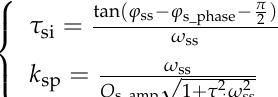
Closed Figure 15. Bode plot of speed open loop and closed loop.